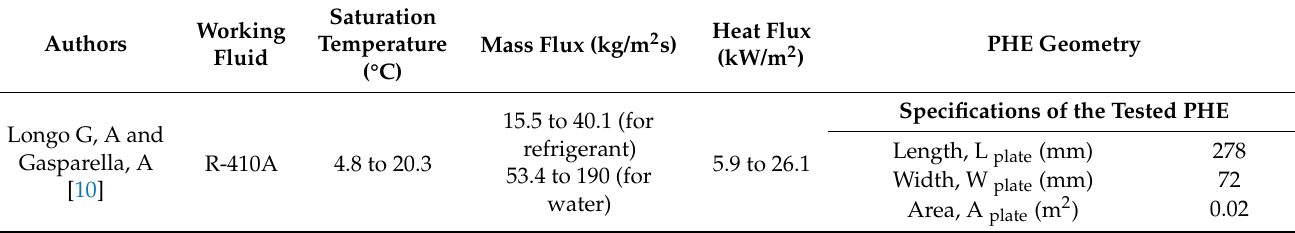
Table 5. Experimental conditions, specifications and dimensions of a plate heat exchangers in the